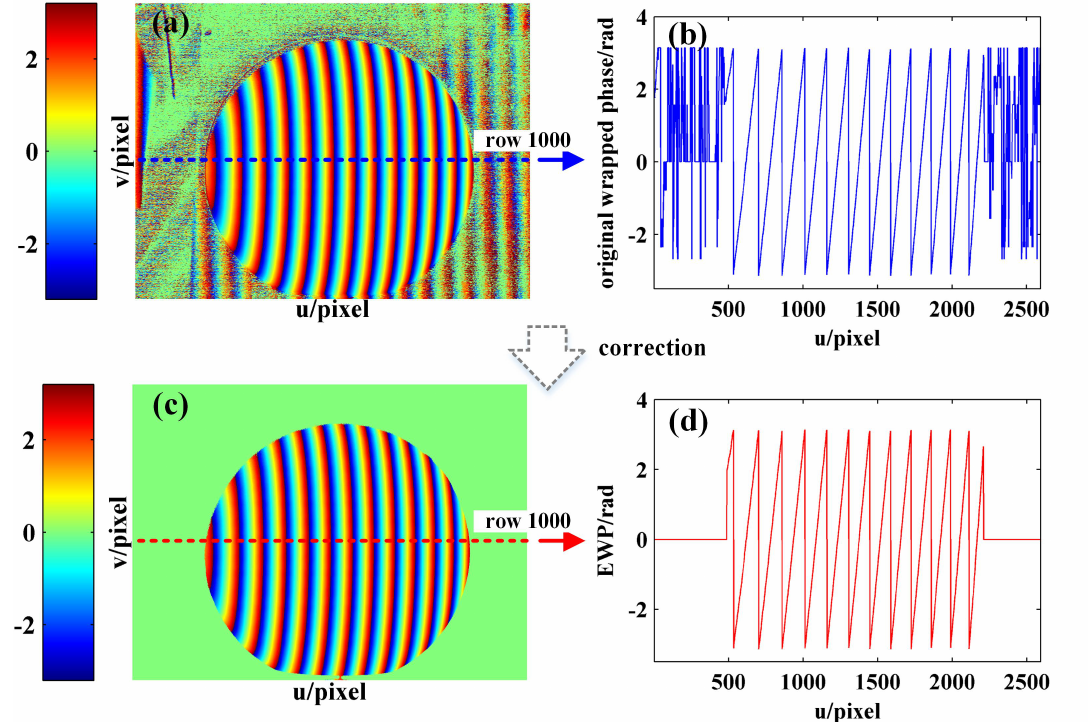
Figure 11. ( a ) Original wrapped phase map; ( b ) original wrapped phase of row 1000; ( c ) EWP map; ( d ) EWP of row